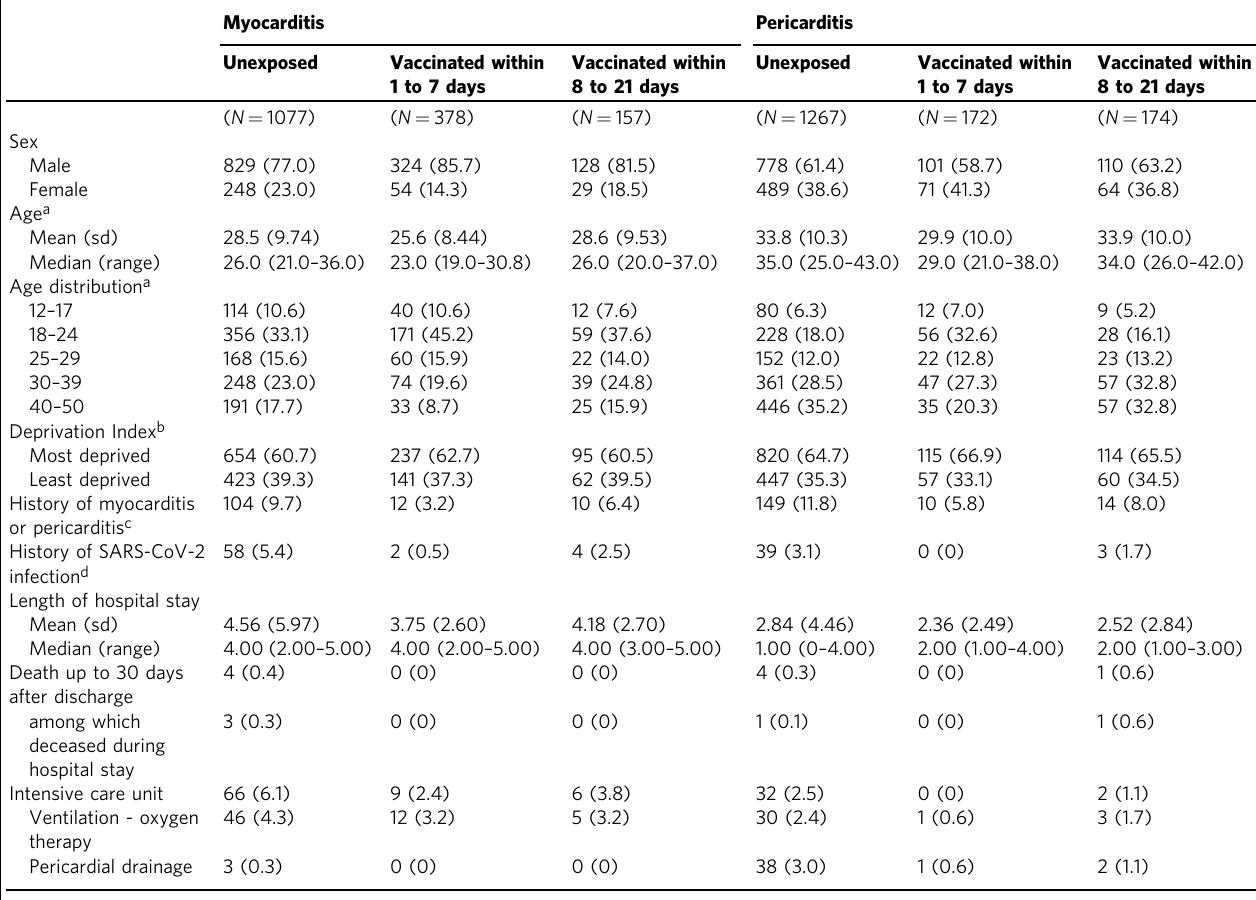
Table 3 Description of hospitalized patients according to the exposure to mRNA